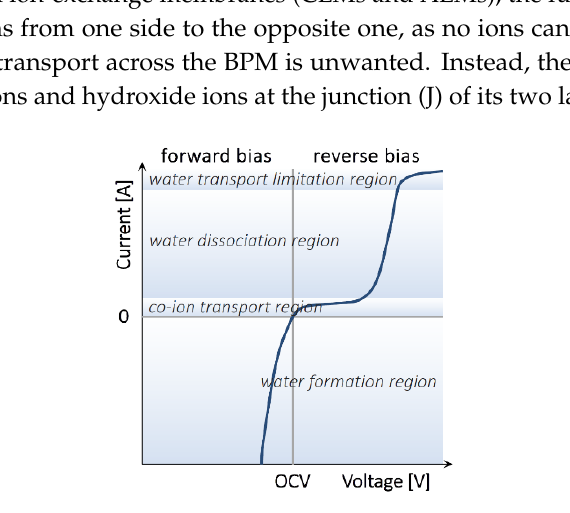
Figure 3. Typical current–voltage curve for a bipolar membrane. For the acid–base flow battery, forward bias corresponds to the battery discharge mode, and reverse bias to battery charge mode.